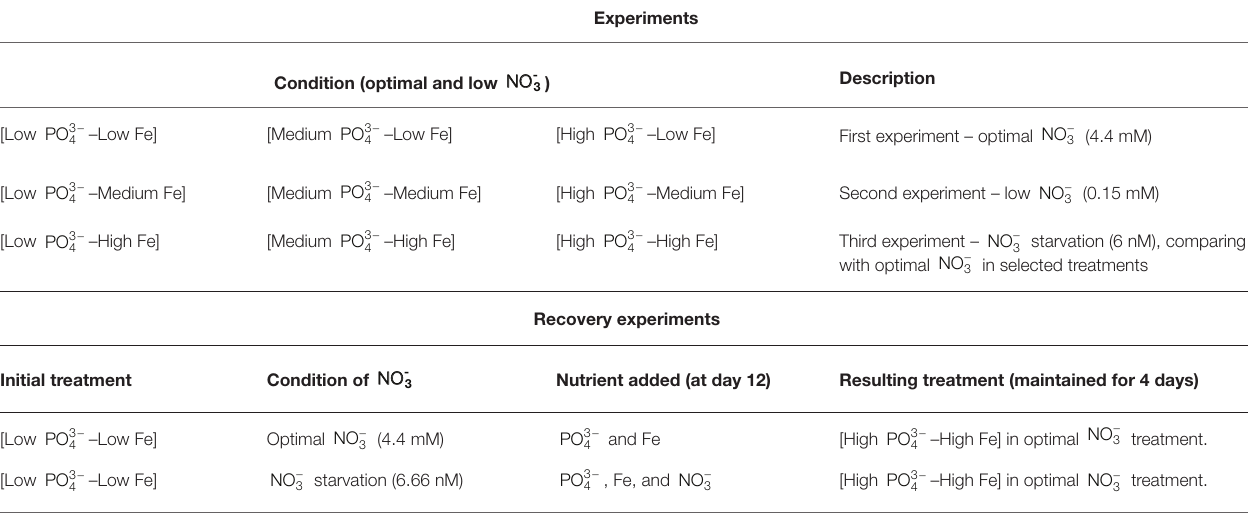
TABLE 1 | List of all experimental treatments conducted in this